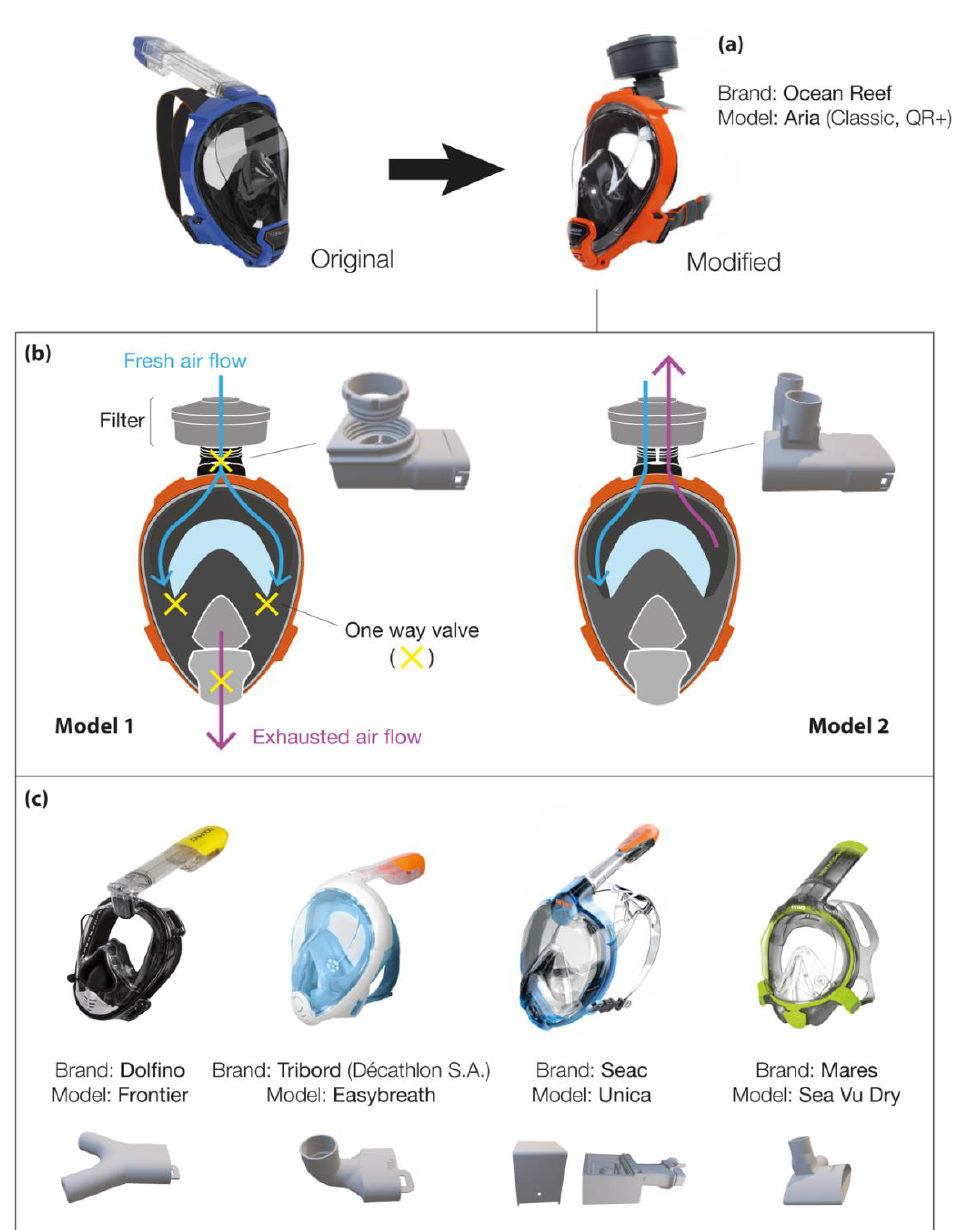
Figure 2. ( a ) Modifications of Ocean Reef’s masks using 3D-printed components; ( b ) different respirator modes obtained with the Ocean Reef’s masks; ( c ) most common masks studied by the community during the COVID-19 pandemic.